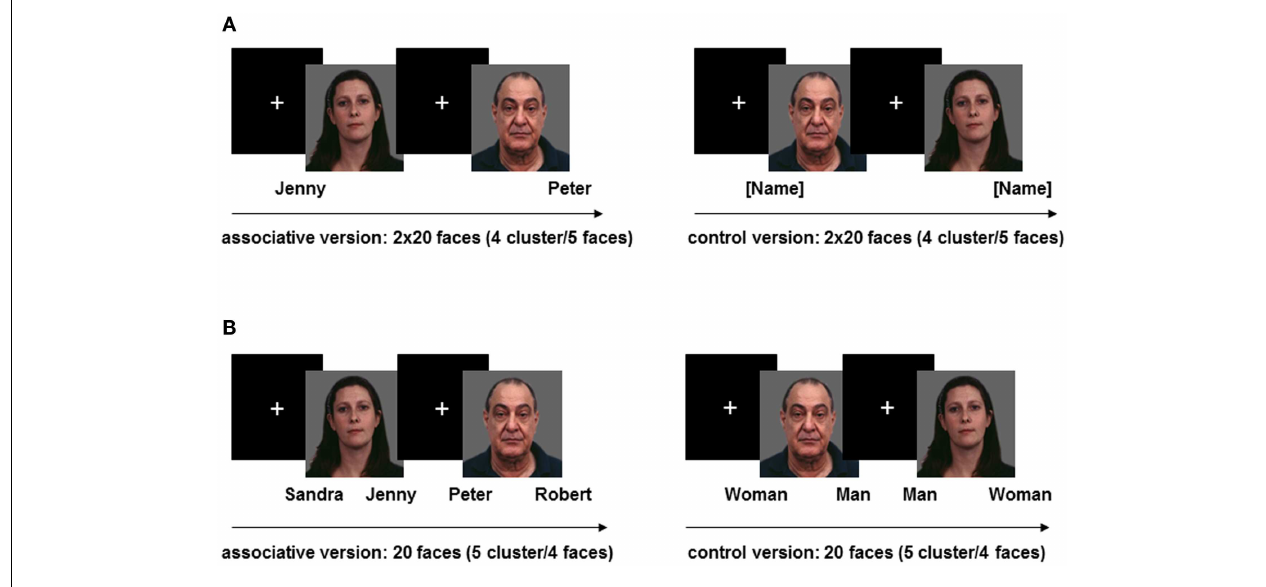
FIGURE 1 | (A) Memory encoding task. (B) Memory recognition